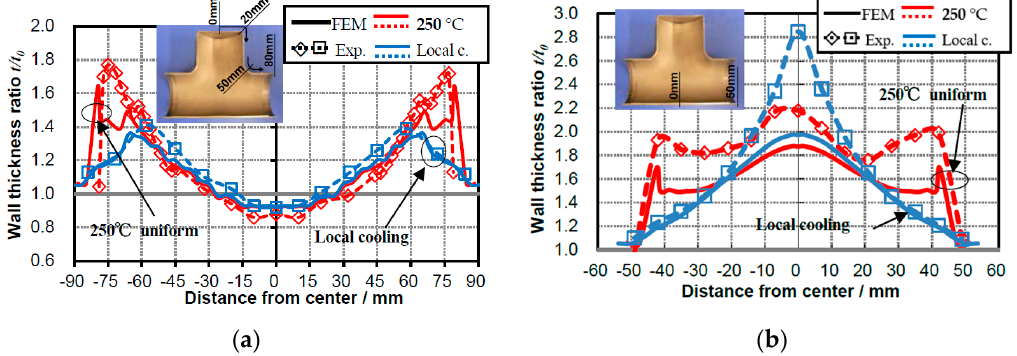
Figure 10. Comparison of wall thickness distribution between uniform temperature and non-uniform temperature fields. ( a ) Bulged side; ( b ) bottom side. Solid line: FE analysis result; dashed line: experimental result; red color: 250 °C; blue color: non-uniform temperature.